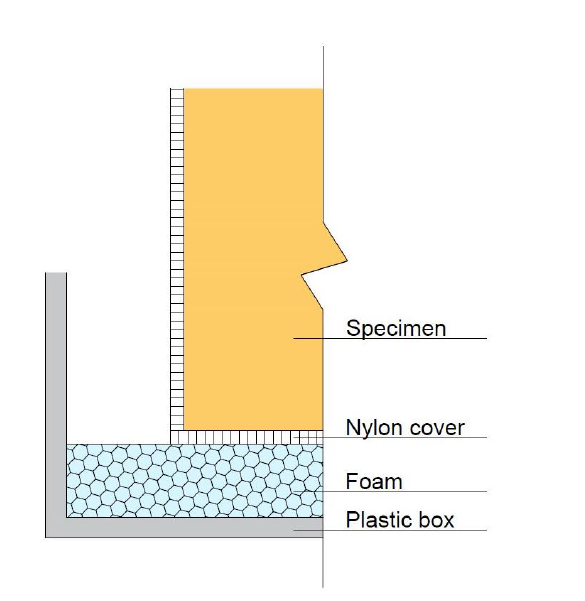
Figure 2. Schema of the water absorption